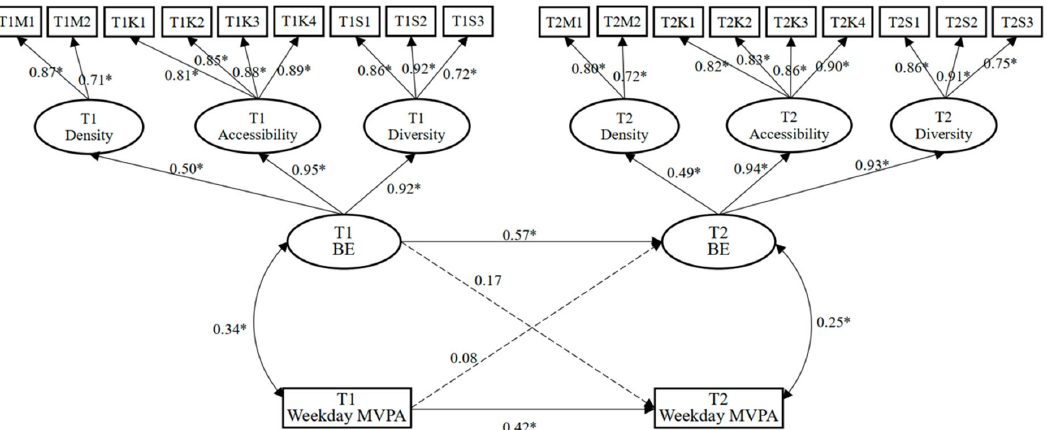
Figure 2. Cross-lagged panel model of built environment (BE) and weekday MVPA. Note: * p < 0.05. The solid line represents significant relationships and the dotted line represents non-significant relationships.